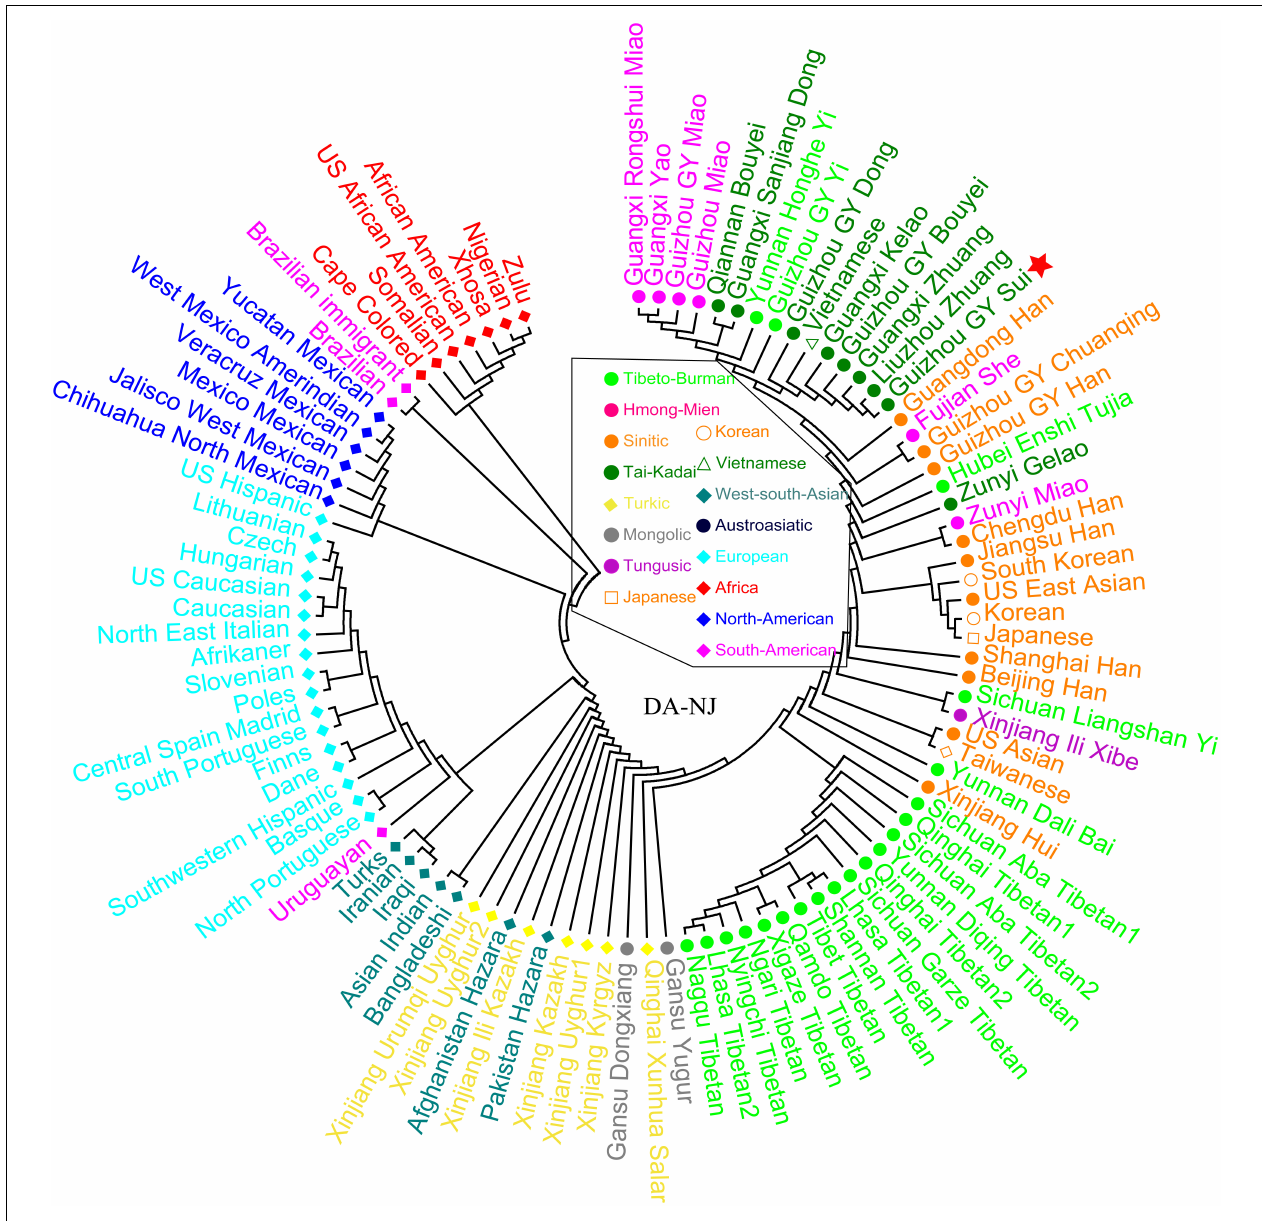
FIGURE 2 | Neighbor-joining polygenetic tree constructed on the D A genetic distance among Guizhou Sui and 99 worldwide reference populations.